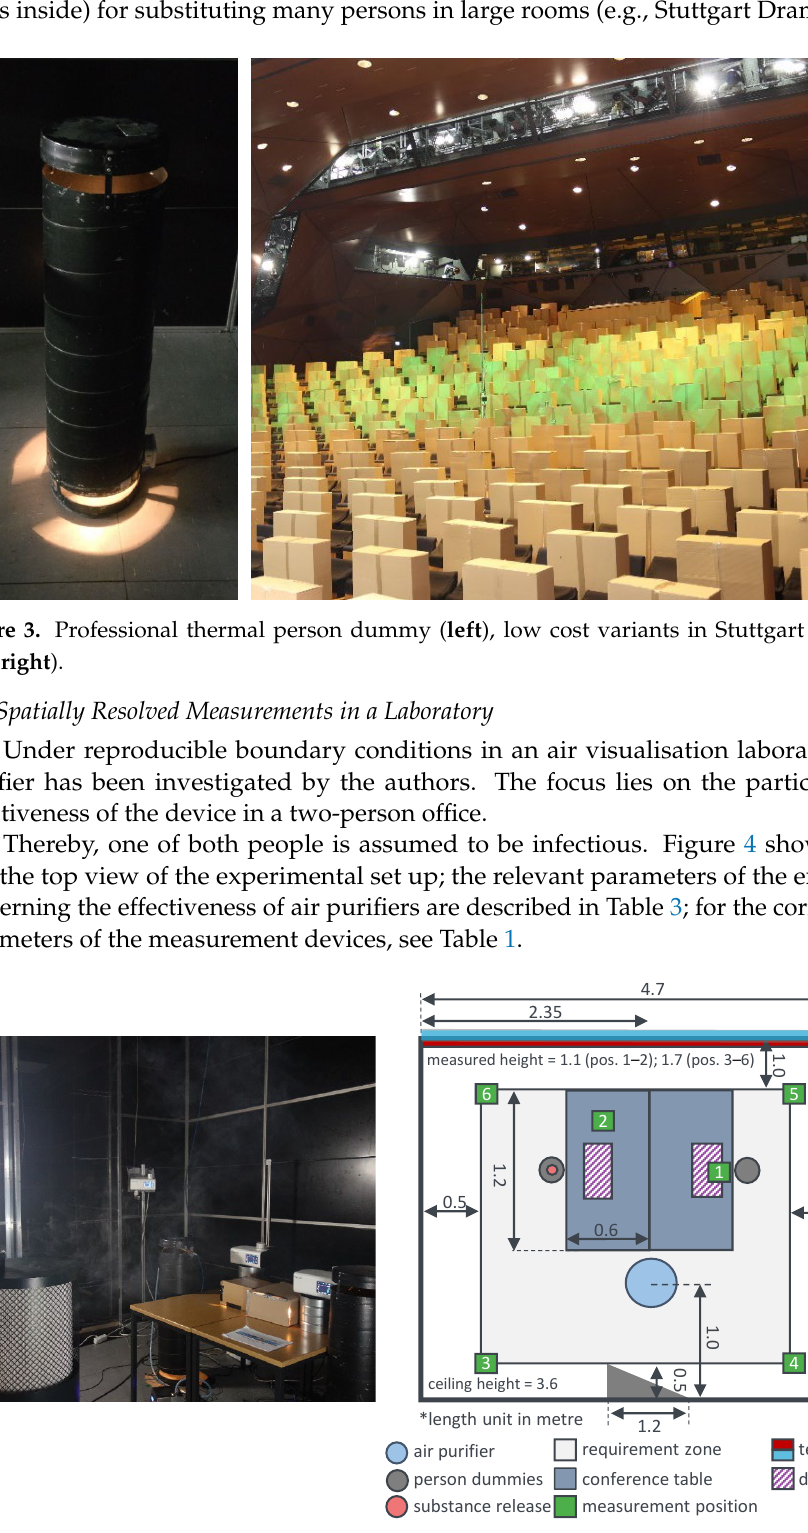
Figure 4. Photo ( left ) and the top view ( right ) of the experimental set up of a two-person office with air purifiers in an air visualisation laboratory. * length unit in